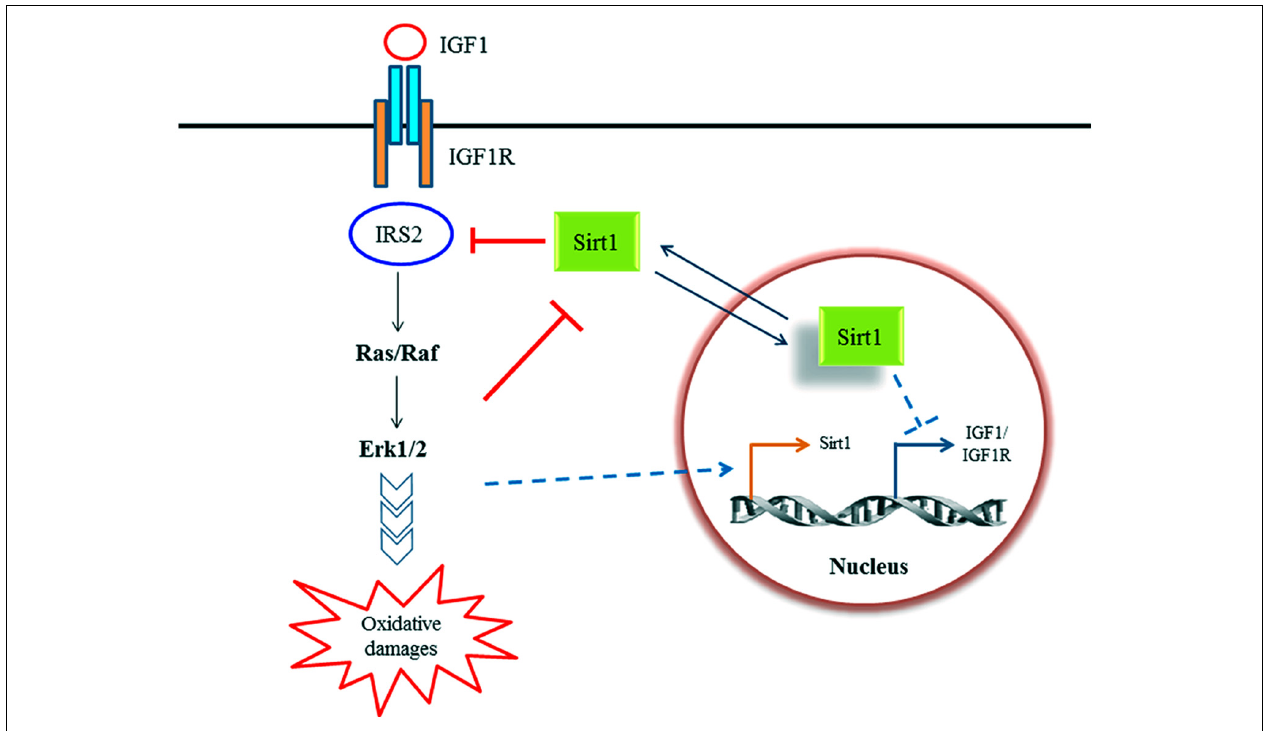
FIGURE 1 |A schematic diagram illustrating the known relationship between Sirt1 and IGF-1 signaling discussed in text. IGF-1 signaling may modulate Sirt1 activity in rat hepatoma cells (Cohen etal., 2004) as well as Sirt1 expression (Vinciguerra etal., 2009) in cardiomyocytes. On the other